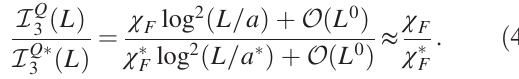
I Q I Q (cid:5) 3 = 3 as a F